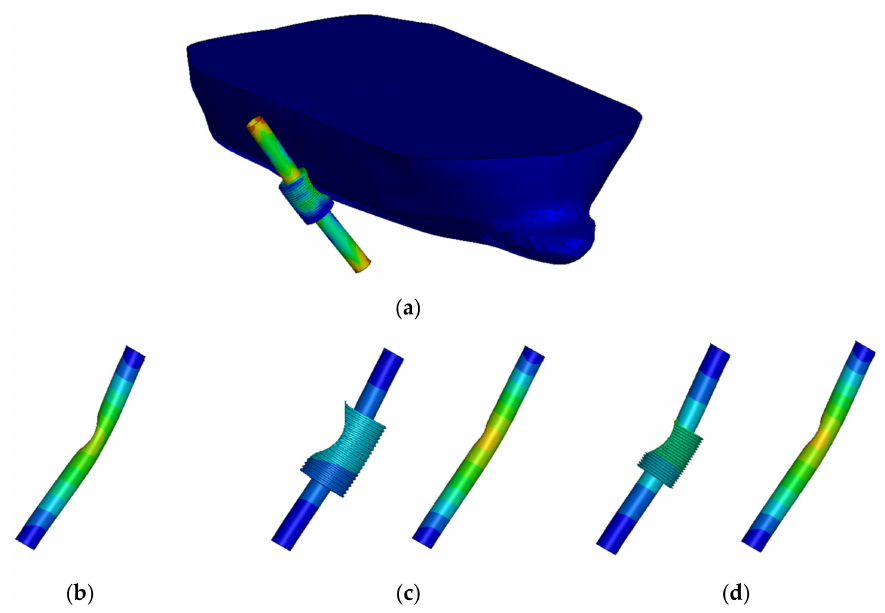
Figure 27. Deformation of the pipe under side collision: ( a ) the overall model; ( b ) unreinforced pipe; ( c ) hexagonal honeycomb reinforced pipe; and ( d ) arrow honeycomb reinforced